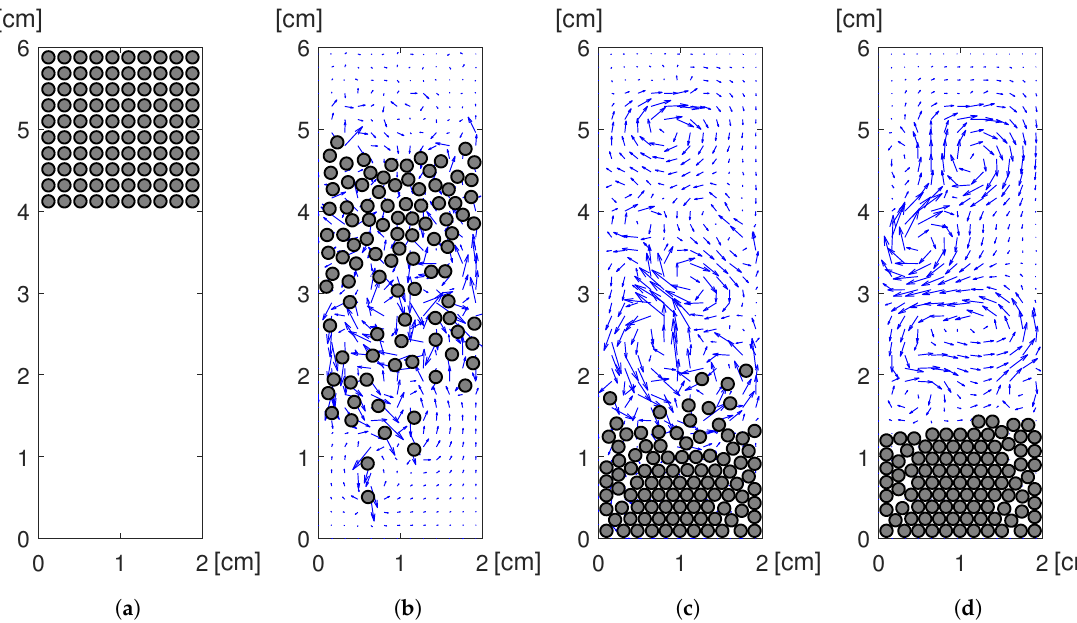
Figure 6. The positions of 10 × 10 circular disks during sedimentation and the associated flow velocity fields at time ( a ) t = 0 s, ( b ) t = 0.6 s, ( c ) t = 1.5 s, and ( d ) t = 2